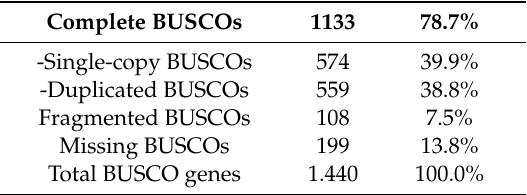
Table 2. Summary of evaluation of the de novo assembly of Eucalyptus globulus roots by